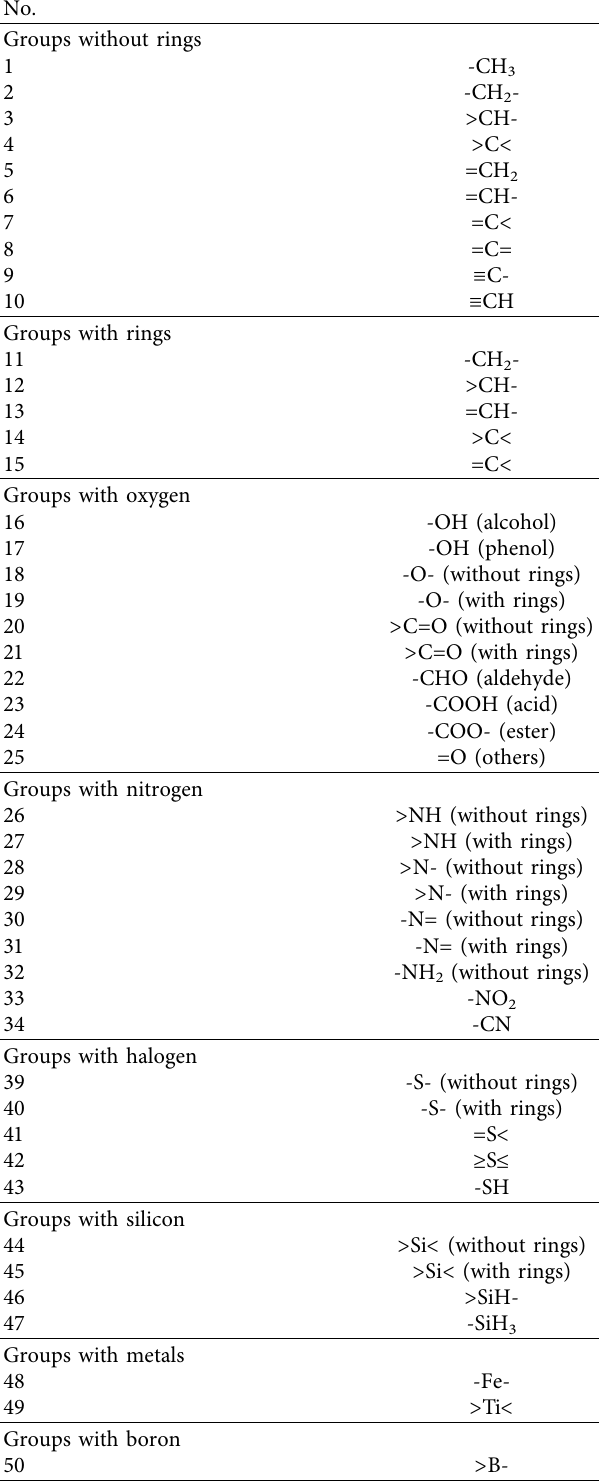
Table 2: Functional groups of the first-order GCMs used to cal- culate critical properties and normal boiling point of pure